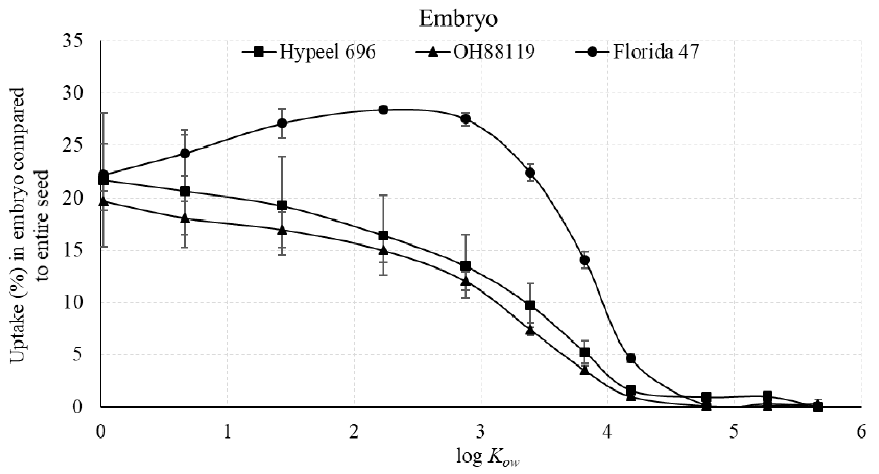
Figure 7. Percent of the absorbed n -alkyl piperonyl amides in seed embryo compared with the entire seed uptake of three tomato varieties. Means with standard error bars are shown.